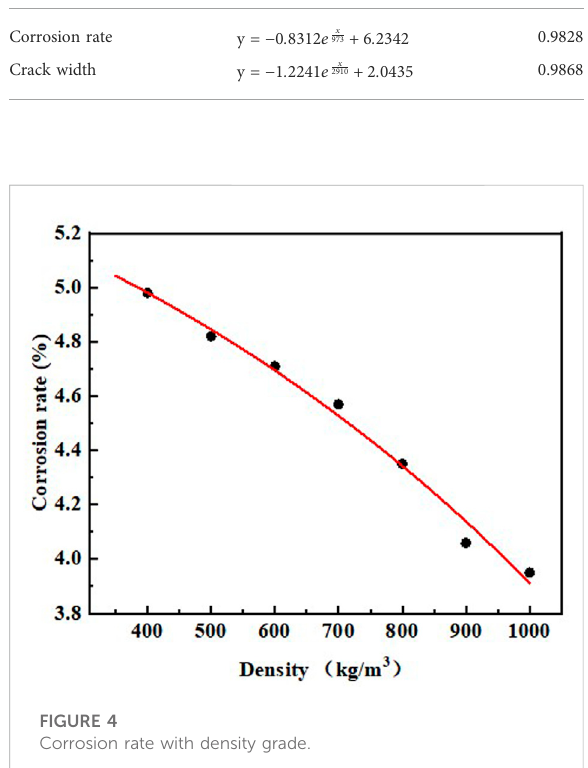
FIGURE 4 Corrosion rate with density